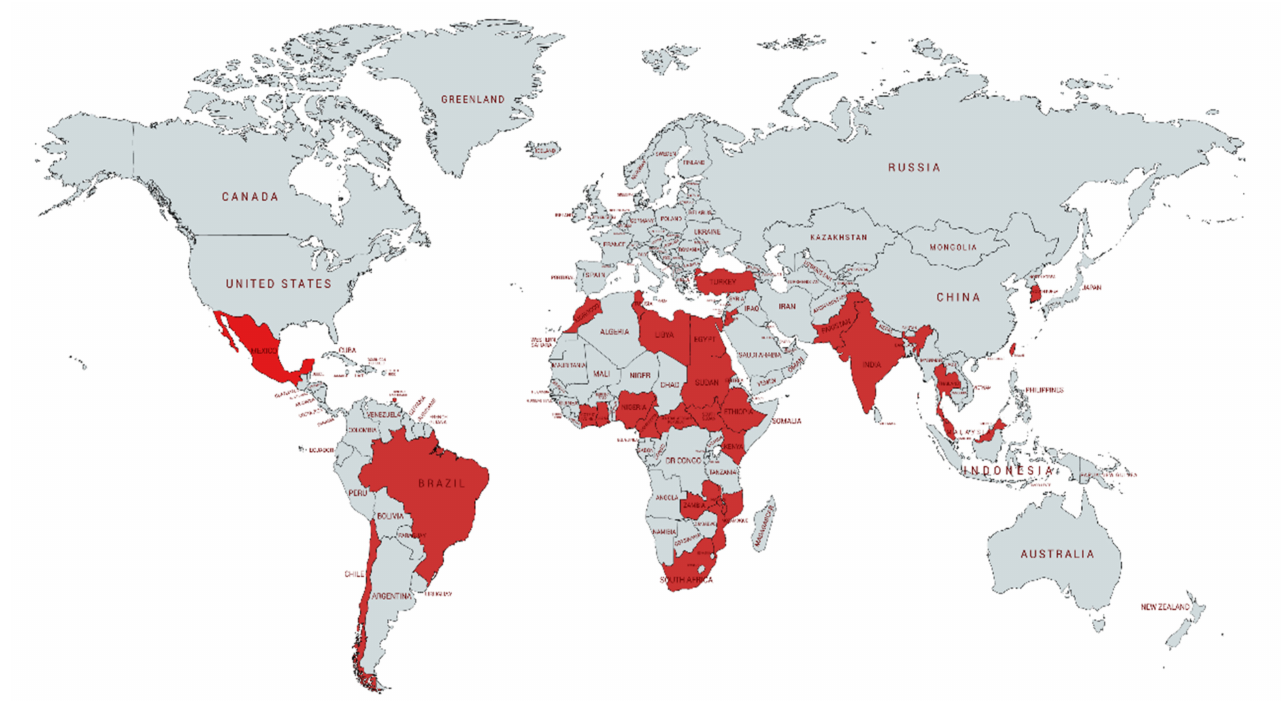
Figure 1. BIM publication distribution in developing